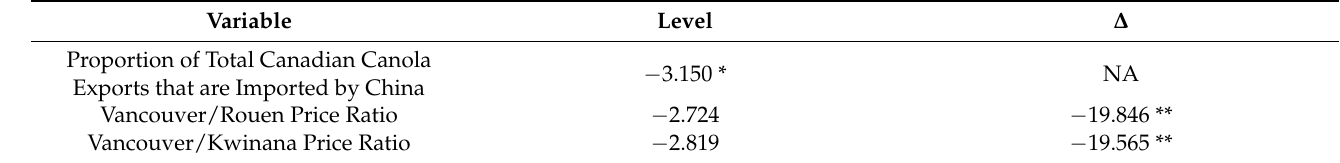
Figure 2. Canola Vancouver/Kwinana (blue) and Vancouver/Rouen (black) Price Ratios from 2014 to 2019. Table 2. Unit Root Test